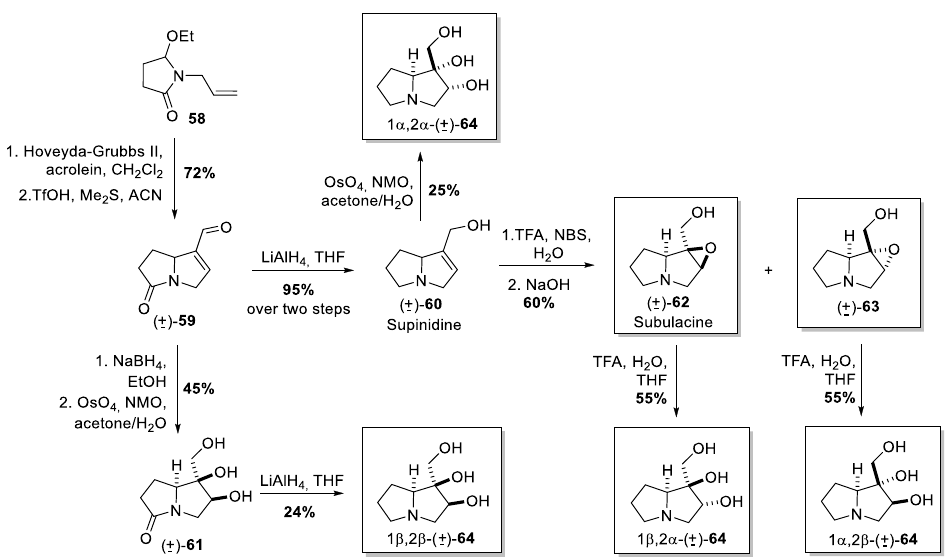
Scheme 8. Synthesis of carbon-branched pyrrolizidines